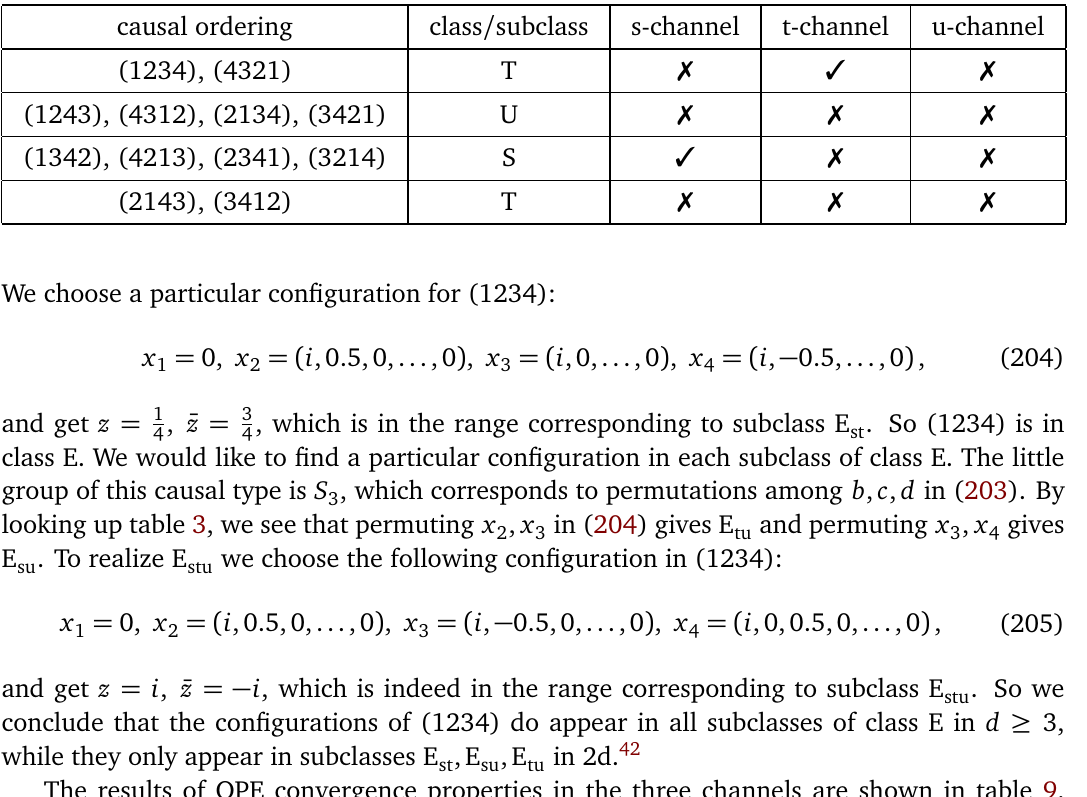
Table 8: OPE convergence properties of type 4 causal orderings